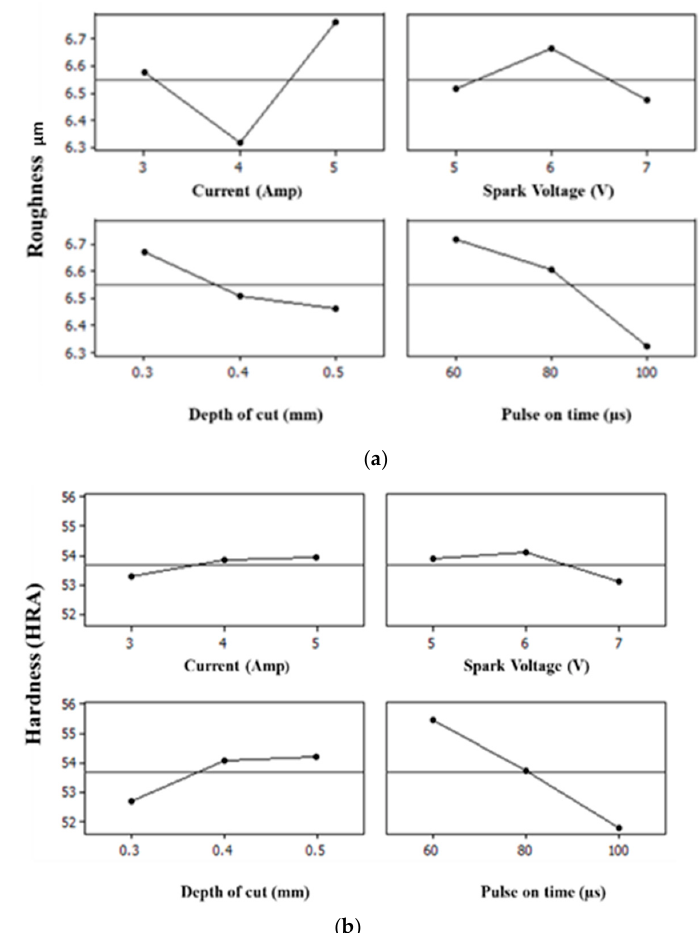
Figure 4. Main effect plots for surface roughness and hardness of the machined profile. Here in above Figure 4, ( a ) shows the effect of all four input parameters on the surface roughness (amplitude parameter), and ( b ) presents the effects of same parameters on the hardness of the machined profile.